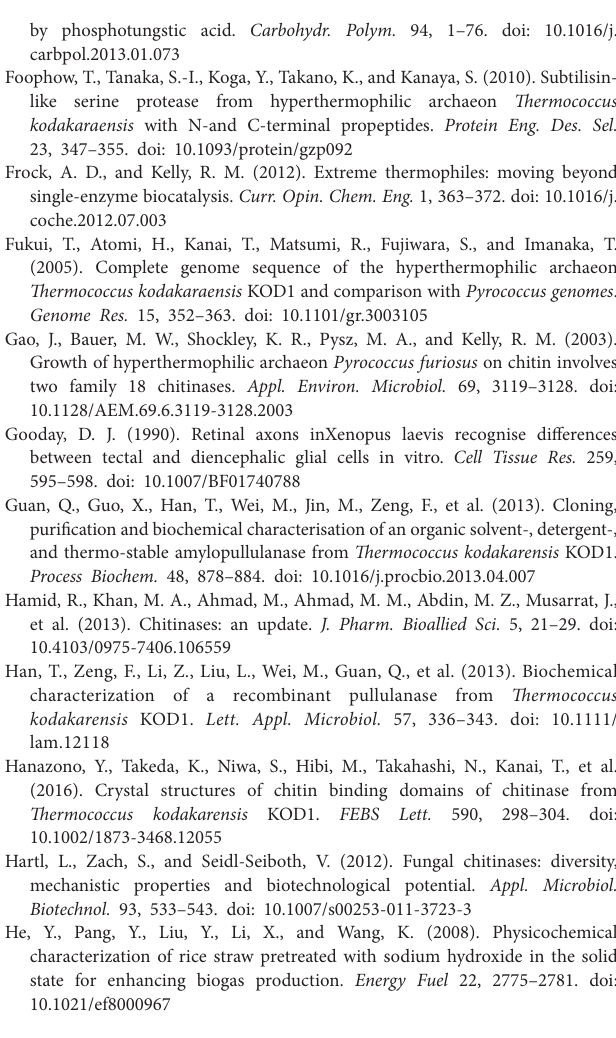
to enhance rice straw degradation to release reducing